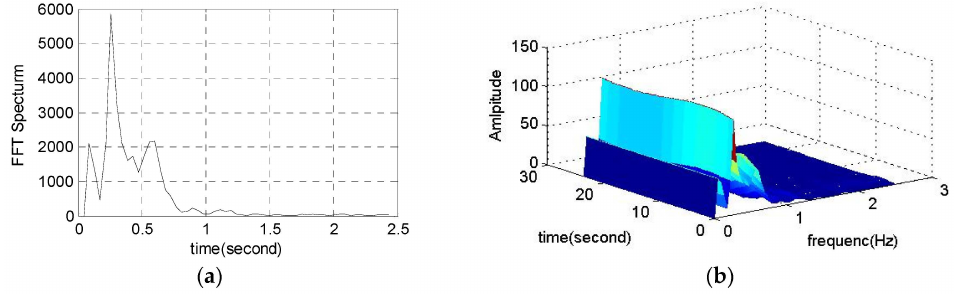
Figure 16. RSSD of power oscillation waveform of the Jiangjiaying-Gaojiang line 1st. Full band time-frequency distribution analysis by FSWT is shown in Figure 17. Three frequency component amplitudes are prominent. They are 0.54 Hz, 0.25 Hz, and 0.12 Hz, respectively. There are three main modes. The highest amplitude is at about 0.25 Hz, so the LFO dominant mode is the 0.25 Hz oscillation mode.